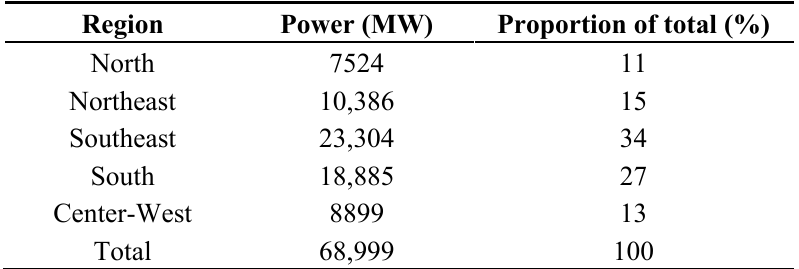
Table 1. Hydroelectric power generation installed in